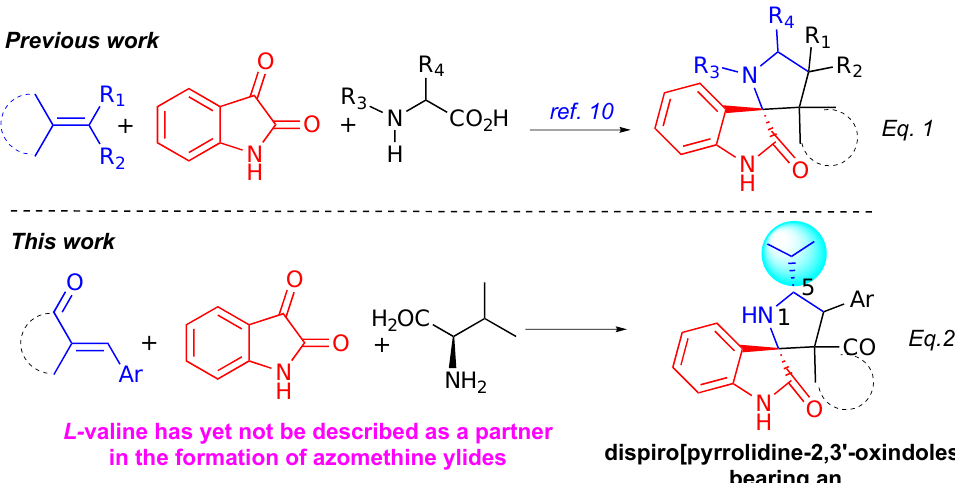
Scheme 1. MCR as tool for the synthesis of pentacyclic spiro[oxindole-2,3′-pyrrolidines].